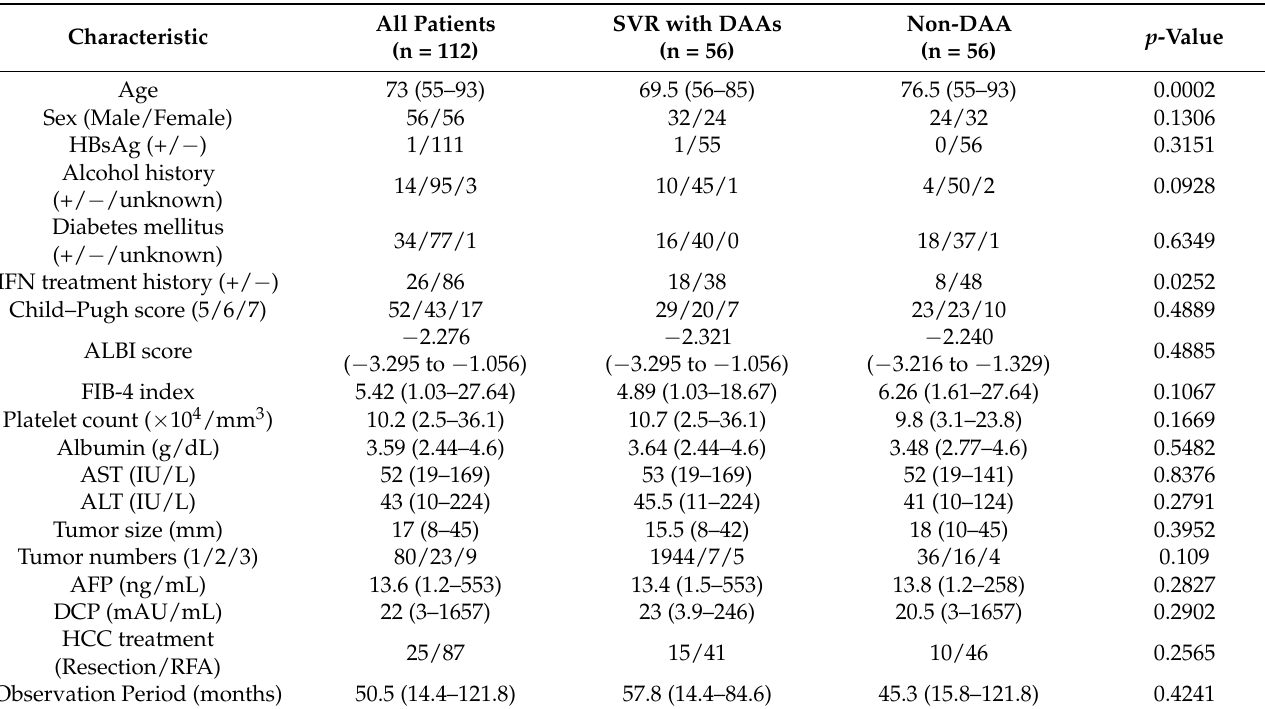
Table 2. Patient characteristics after propensity score